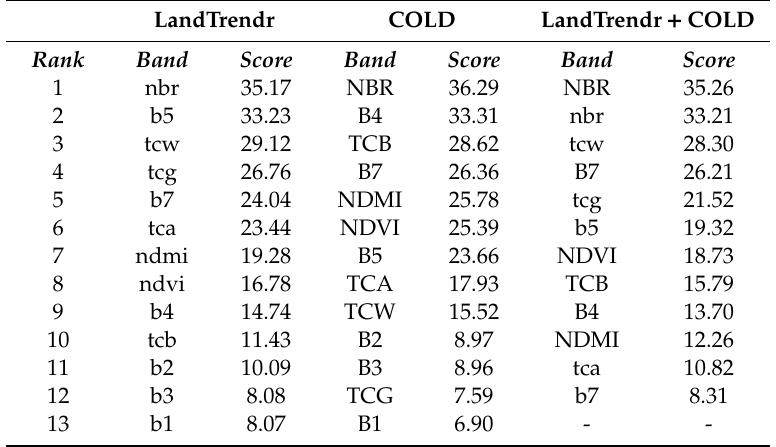
Table 2. Weighted scores and ranks for each band used in the LandTrendr, COLD, and combined models. LandTrendr COLD LandTrendr + COLD Rank Band Score Band Score Band Score 1 nbr 35.17 NBR 36.29 NBR 35.26 2 b5 33.23 B4 33.31 nbr 33.21 3 tcw 29.12 TCB 28.62 tcw 28.30 4 tcg 26.76 B7 26.36 B7 26.21 5 b7 24.04 NDMI 25.78 tcg 21.52 6 tca 23.44 NDVI 25.39 b5 19.32 7 ndmi 19.28 B5 23.66 NDVI 18.73 8 ndvi 16.78 TCA 17.93 TCB 15.79 9 b4 14.74 TCW 15.52 B4 13.70 10 tcb 11.43 B2 8.97 NDMI 12.26 11 b2 10.09 B3 8.96 tca 10.82 12 b3 8.08 TCG 7.59 b7 8.31 13 b1 8.07 B1 6.90 -